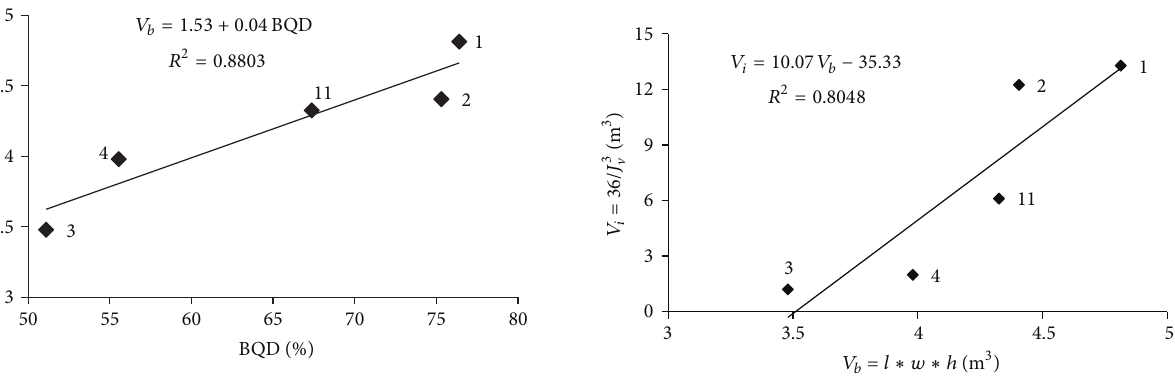
Figure 9: Relationship between the estimated in situ block volume ( 𝑉 𝑖 ) and the mean volumes of the blocks (𝑉 𝑏 ) produced in the Karaburun limestone